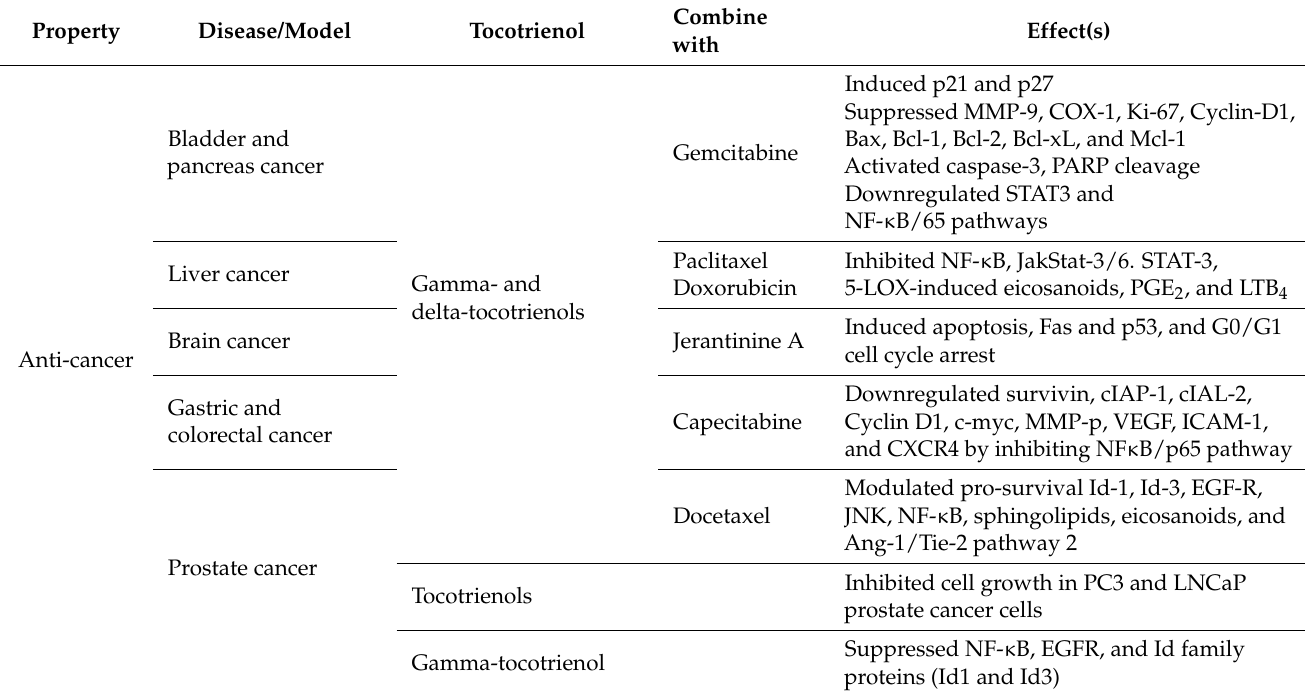
Table 1. The multifaceted properties of